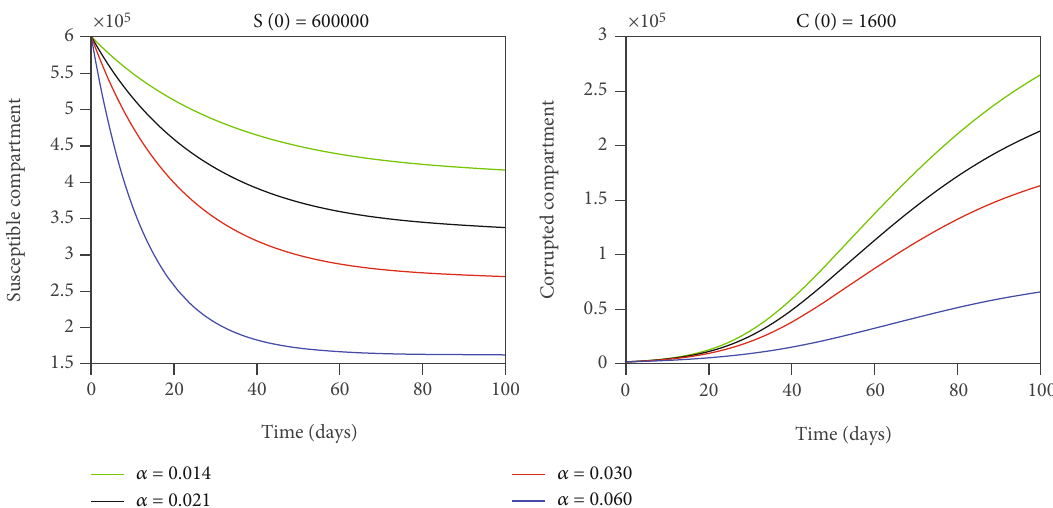
Figure 3: Susceptible and corrupted population with varying proportion at which susceptible, corrupted, and jailed becomes honest, α